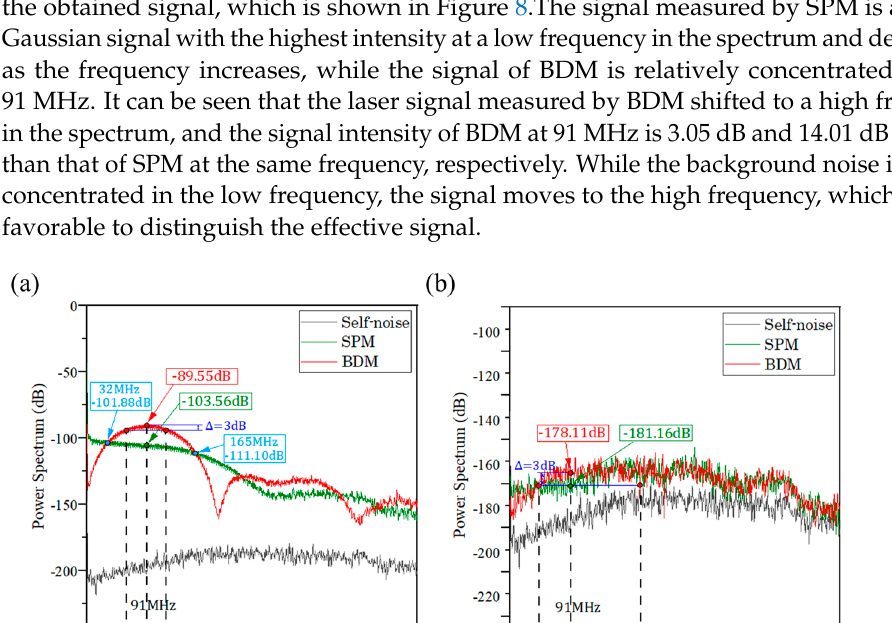
Figure 7. Comparison of the signals acquired by SPM and BDM.